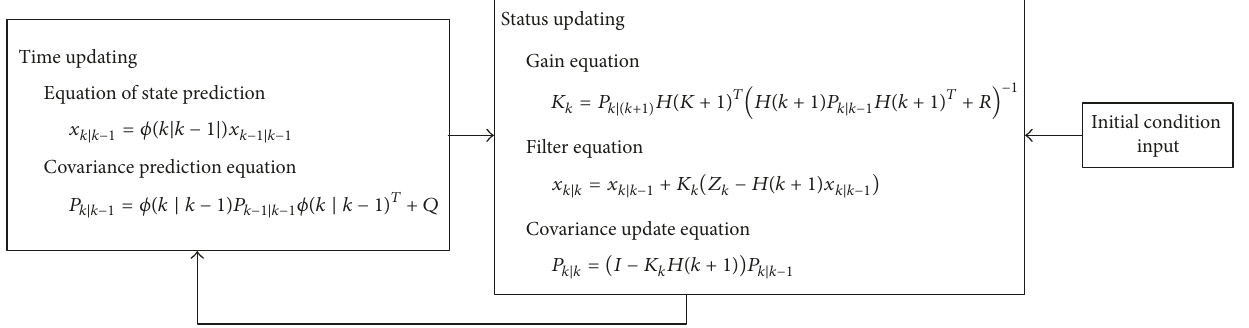
Figure 1: EKF algorithm